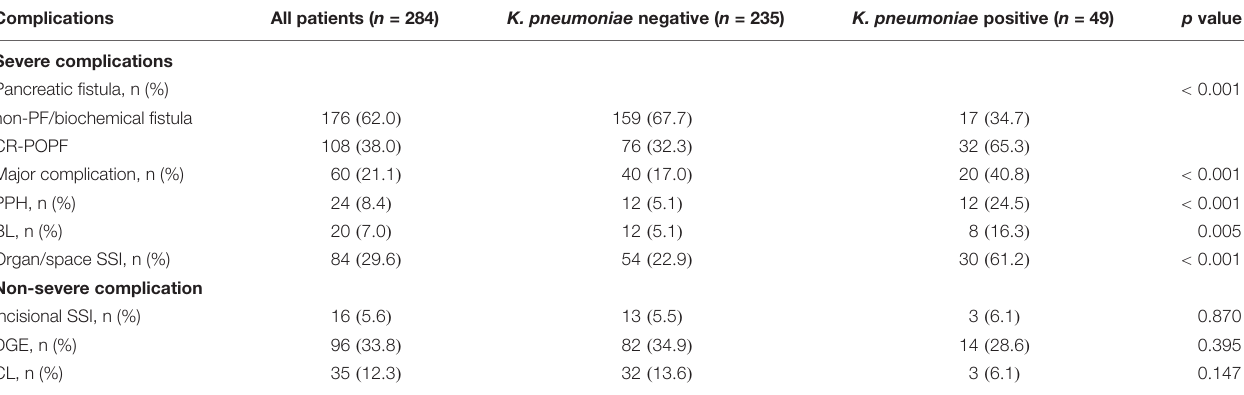
TABLE 3 | Postoperative complications of all cohorts and stratified according to the contamination of K. pneumoniae .